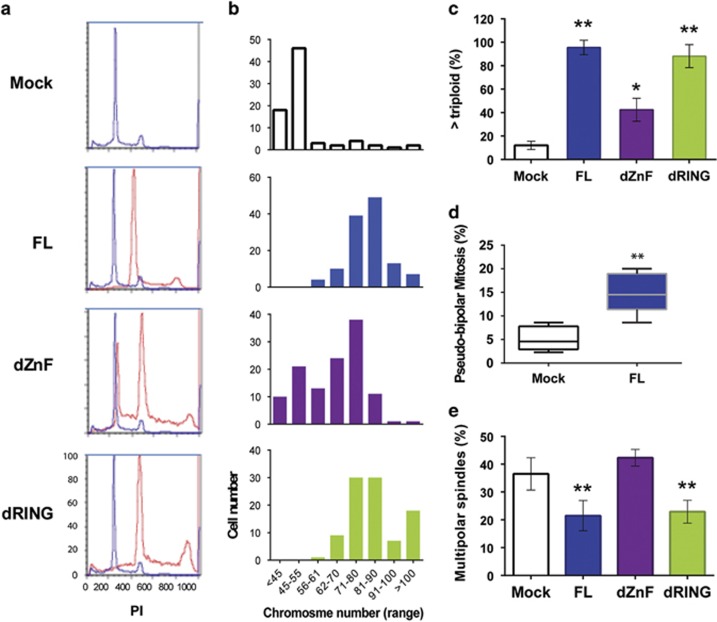
Zn-finger domain of MdmX suppresses genome instability in p53-deficient human cells. (a) DNA content determined by propidium iodide staining of human breast tumor MB157 cells transduced with MdmX FL or deletion mutants. DNA content of experimental cells (red histograms) was superimposed over the DNA content of Mock control cells (blue histograms). (b) Metaphase spread analysis for chromosome number per cell (in indicated ranges) in transduced MB157 human breast tumor cells. At least 50 metaphases were scored per cell line. (c) Summary of chromosome analyses showing cell fraction with larger than triploid genome in population of transduced MB157 cells. Error bars represent mean±s.d. from three to four experiments with at least 50 metaphase cells scored per experiment. (d) Frequency of pseudo-bipolar mitosis expressed as a percent of total mitotic events in population of MdmX-transduced MB157 cells. Spindles with amplified centrosomes clustered around the opposite pools (see Figure 3d, right panel) were scored as pseudo-bipolar mitosis. Results from five experiments with more than 100 mitotic events per experiment are shown in Box-whiskers plots. (e) Frequency of multipolar spindles in the populations of transduced MB157 cells. More than 200 mitotic spindles were scored per experiment. Error bars represent mean±s.d. from average of five experiments for each cell line. P-values relative to Mock control: **P<0.005; *P from 0.005 to 0.05, unpaired t-test.